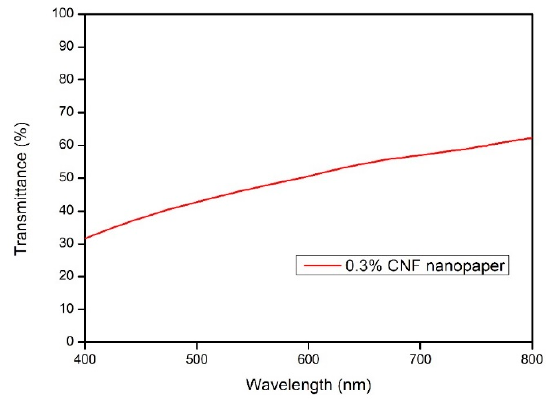
Figure 3 . The UV/Vis trasmittance of 0.3 wt % CNF nanopaper.